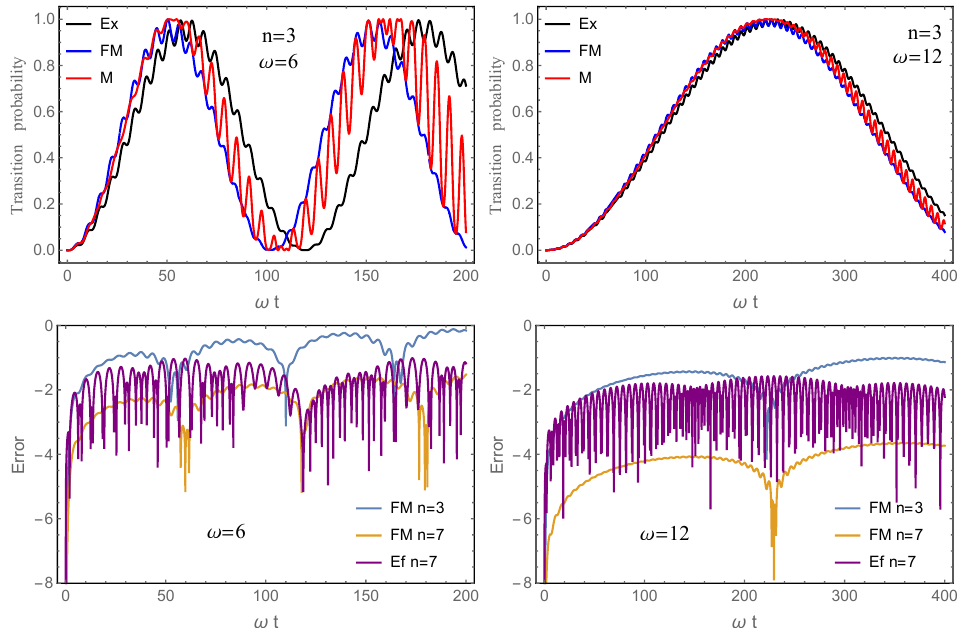
Figure 2. Top: transition probability for the three-lambda system with f ( t ) = e i ω t obtained with Floquet–Magnus (blue line) and Magnus expansion (red line), both with n = 3 terms. Left diagram is for ω = 6, right diagram is for ω = 12. Bottom: error (in logarithmic scale) as a function of time for Floquet–Magnus with n = 3 and n = 7 terms, and the effective solution with n = 7 terms (purple). Here, the approximate solution is obtained as U ( t ) = exp ( ˜ Ω ( t )) exp ( − i tH h ef /¯